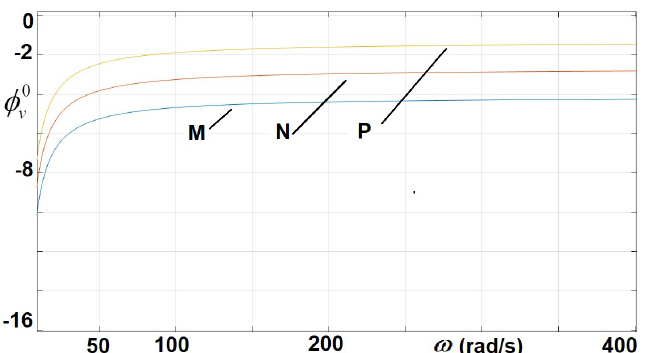
Figure 7. Hardware-OCC. Angle φ v (0.1 0 /div) vs. angular frequency (rad/s) as a function of the dc = V 0 p = 467 V, T sw = 8.33 ms, C = 1000 µ F, L = 1 mH, K p 1 = K I 1 = K I = current I 0 , V ∗ 0